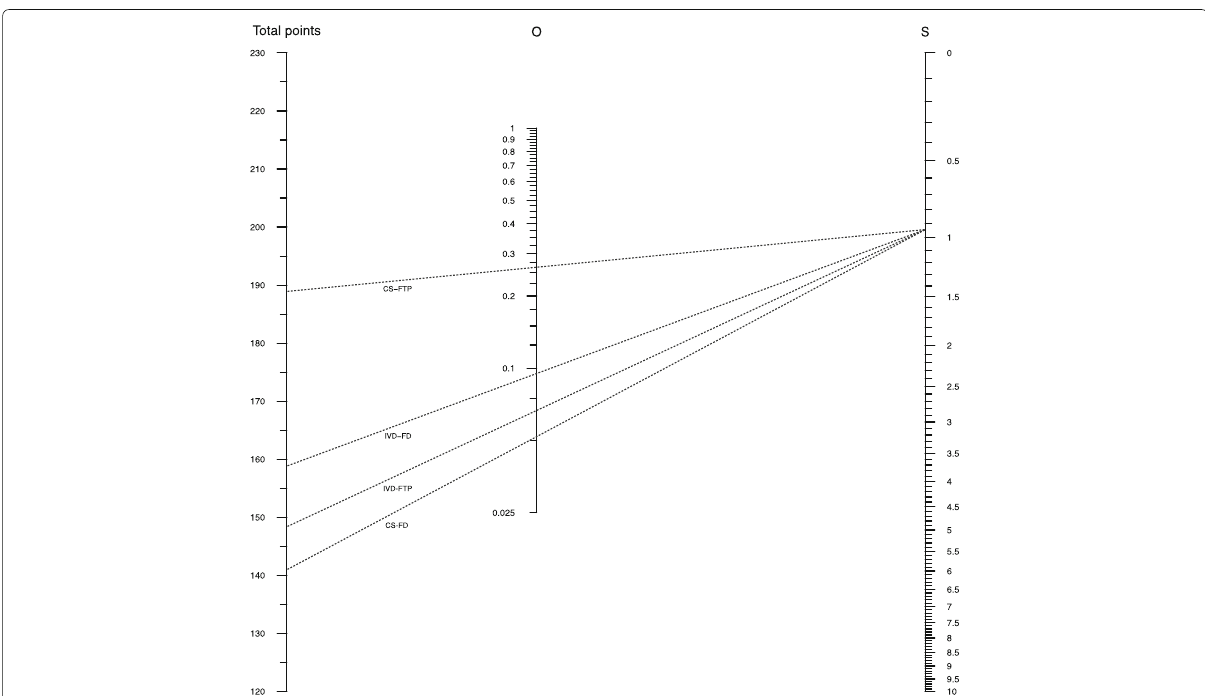
Fig. 3 Nomogram—hypothetical case study based on multinomial prediction model in Schuit et al. Case description: Maternal age: 32 years; gestational age: 40 weeks; nulliparous; birth weight: 3540 g, maternal diabetes. Abbreviations: instrumental vaginal delivery (IVD), caesarean section (CS), fetal distress (FD), failure to progress